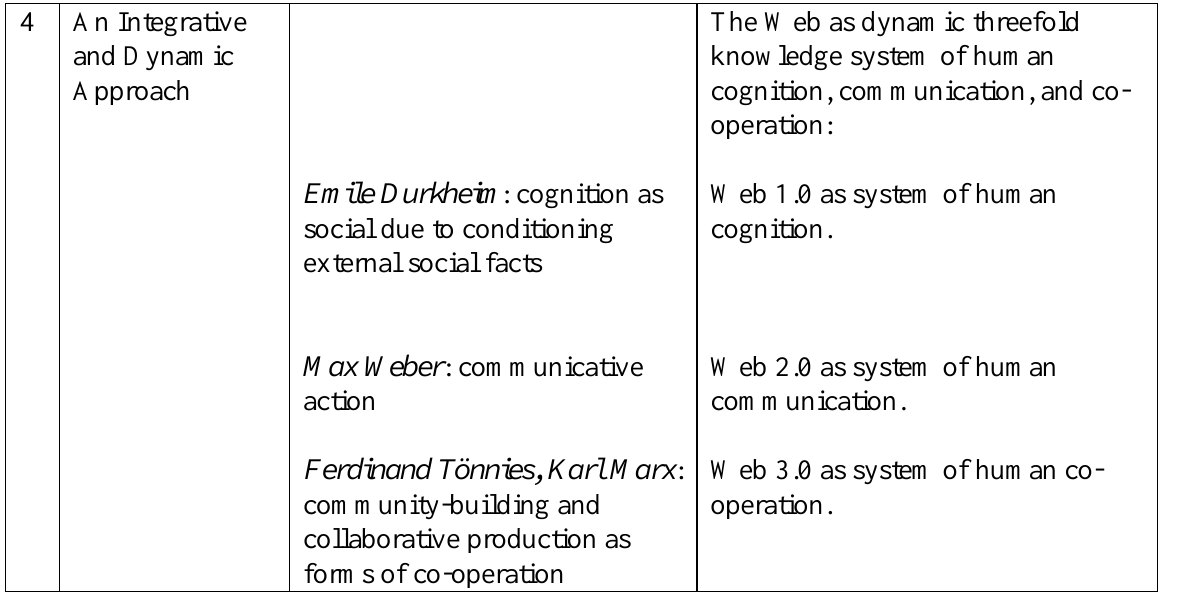
Table 2. Integrative and dynamic understanding of Social Software and Web